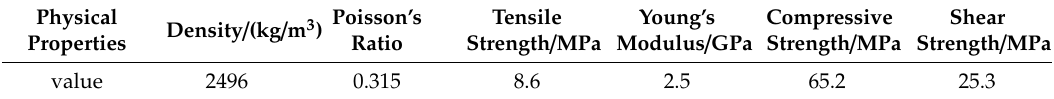
Table 1. Physical properties of rock used in the Figure 2. Schematic diagram and real image of the non-contact strain measurement system.